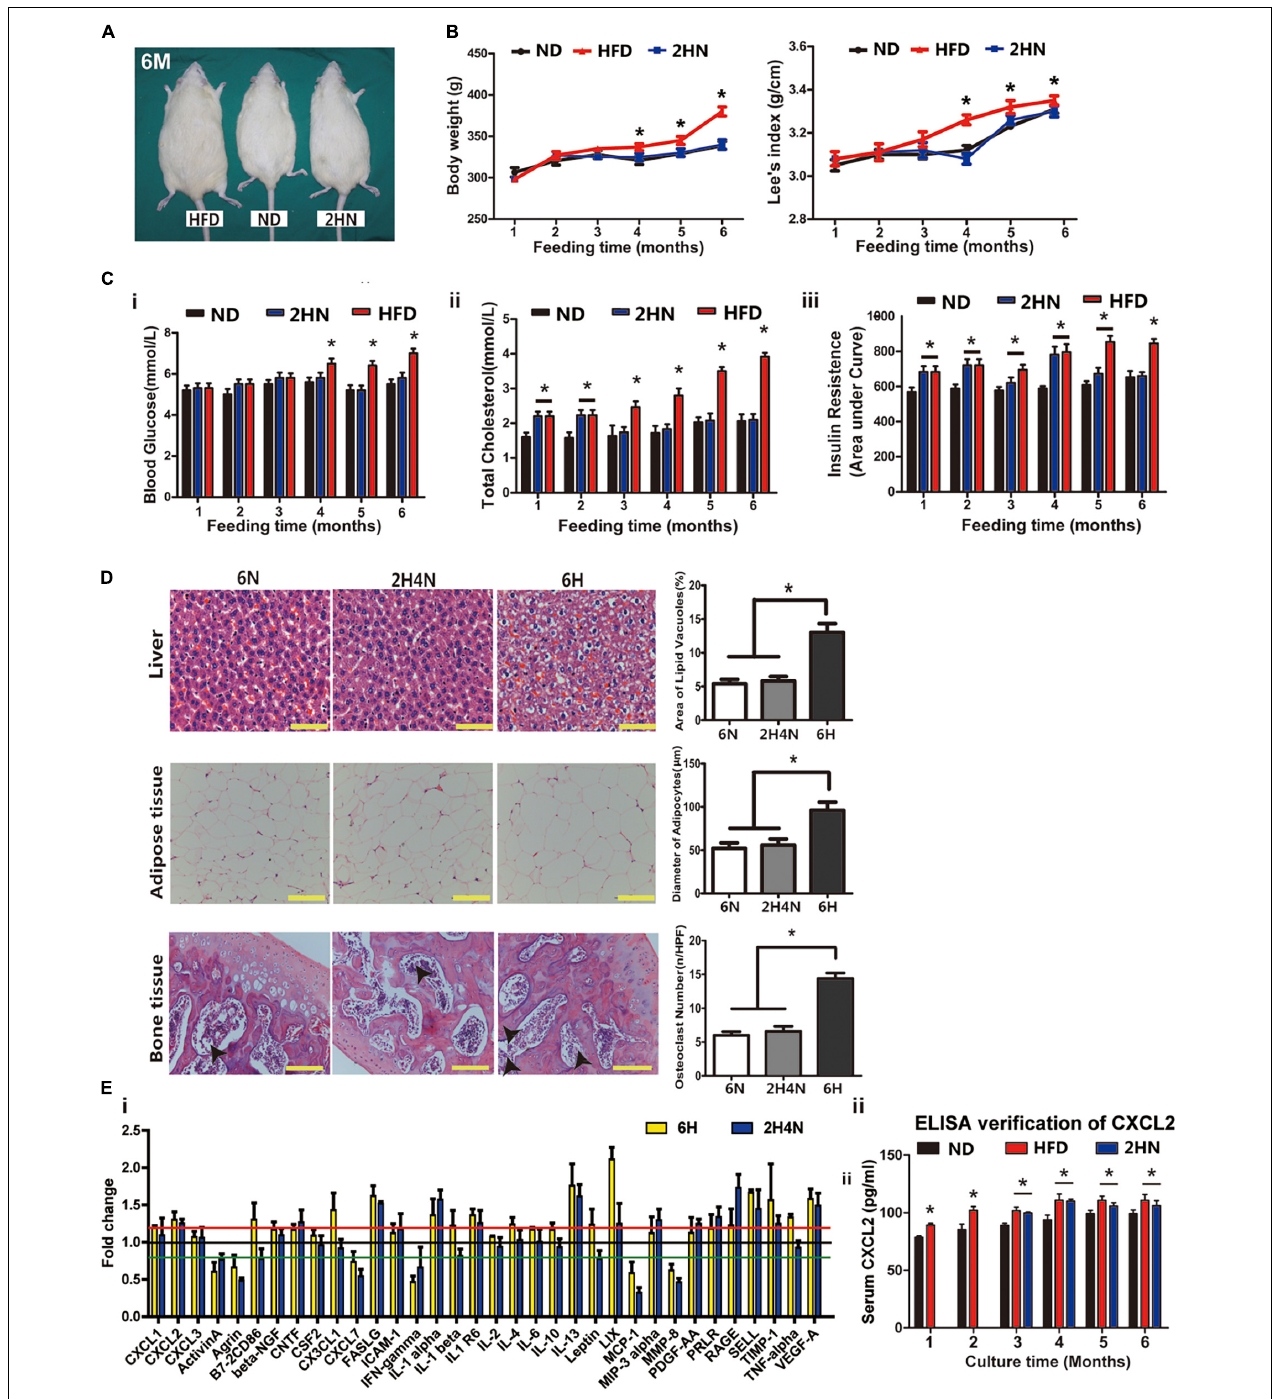
FIGURE 7 | Dietary intervention restores the physio-biochemical characteristics of the HD rats while the serum cytokine profiles remain changed. (A) Sizes of representative rats fed for 6 months in ND, HFD and 2HN groups. Scale bar, 5 cm. (B) Body weight and Lee’s index of rats in ND, HFD and 2HN groups over 6 months of feeding ( n = 10). Significance was calculated by one-way ANOVA followed by Tukey’s post hoc test, * p < 0.05 (ND and 2HN versus HFD). (C) Blood glucose (i) , total cholesterol level (ii) , and insulin tolerance test (iii) of rats ( n = 10) in ND, HFD and 2HN groups over 6 months of feedings. Significance was calculated by one-way ANOVA followed by Tukey’s post hoc test, * p < 0.05. (D) Histological analysis of liver, adipose and bone tissues of rats in 6N, 6H, and 2H4N groups. Values are represented as mean ± SEM. Scale bars, 50 µ m. (E) Serum cytokine profiles of rats in 6H and 2H4N groups, presented as the mean of fold changes ± SEM ( n = 3) in comparison with 6N rats (i) . ELISA verification for serum CXCL2 levels in rats over 6 months of feedings (ii) . Significance was calculated by student’s t -test, * p < 0.05.